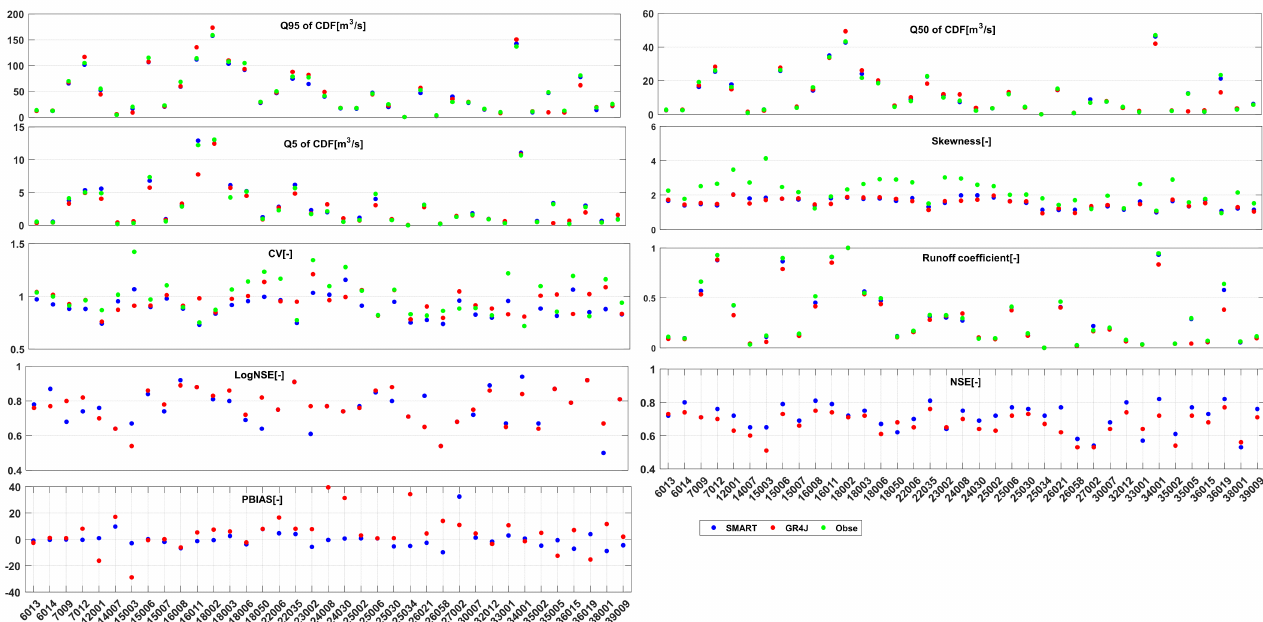
Figure 4. Model performance for various hydrological signatures (ability to capture different per- centiles of the CDF of daily flows (Q95, Q50, Q5), the skewness, and the Coefficient of Variation (CV) of observations and the runoff coefficient), together with PBIAS, NSE, and LogNSE skill scores for each catchment over the evaluation period